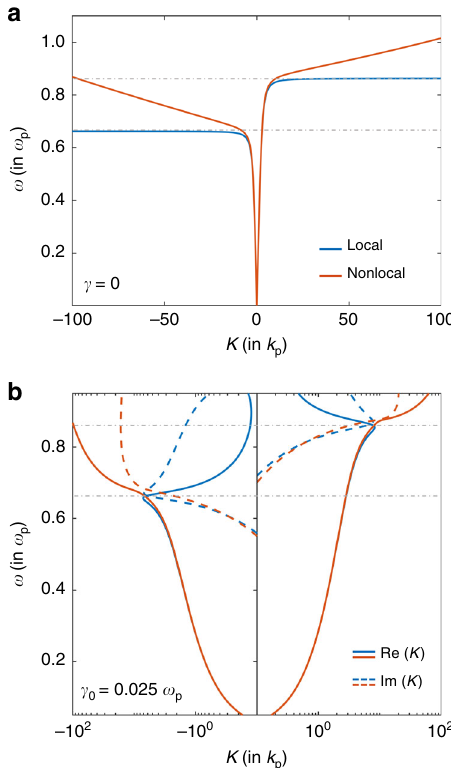
Fig. 2 Dispersion relations in the local and hydrodynamic Drude models. Dispersion relation for the interface considered in ref. 18 , in the local (blue) and nonlocal (red) models. a A fl at dispersion relation is obtained in the lossless ( γ 0 = 0) local Drude model, resulting in a unidirectional gap indicated by the dotted gray lines. This gap is removed in the hydrodynamic Drude model with a high- K counter-propagating wave. b Real (solid line) and imaginary (dotted line) parts of K when γ 0 = 0.025 ω p in the local (blue) and the nonlocal (red) models. Landau damping is self-consistently incorporated in the nonlocal model. Re ð K Þ < Im ð K Þ in the unidirectional gap in the local model, while Re ð K Þ > Im ð K Þ in the nonlocal model. Note that K ∕ k p is in log